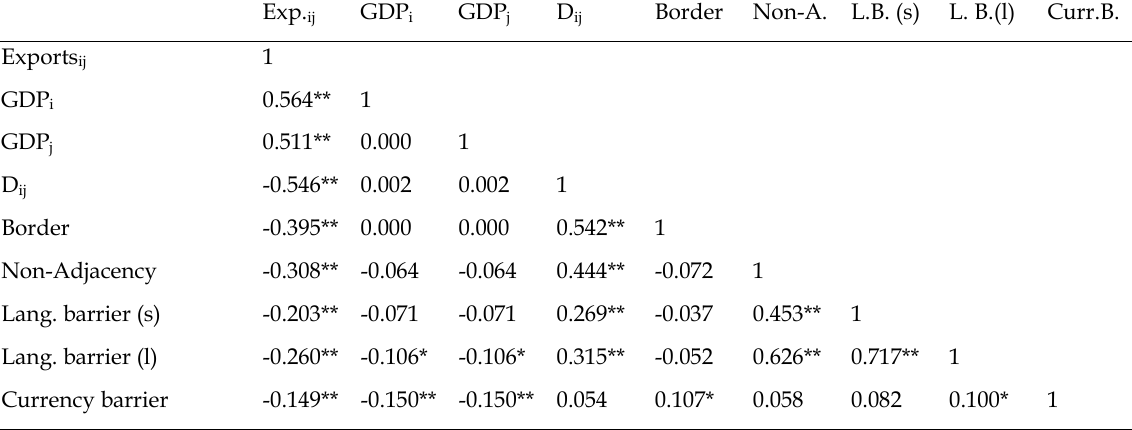
Table 1. Pearson's correlation matrix between